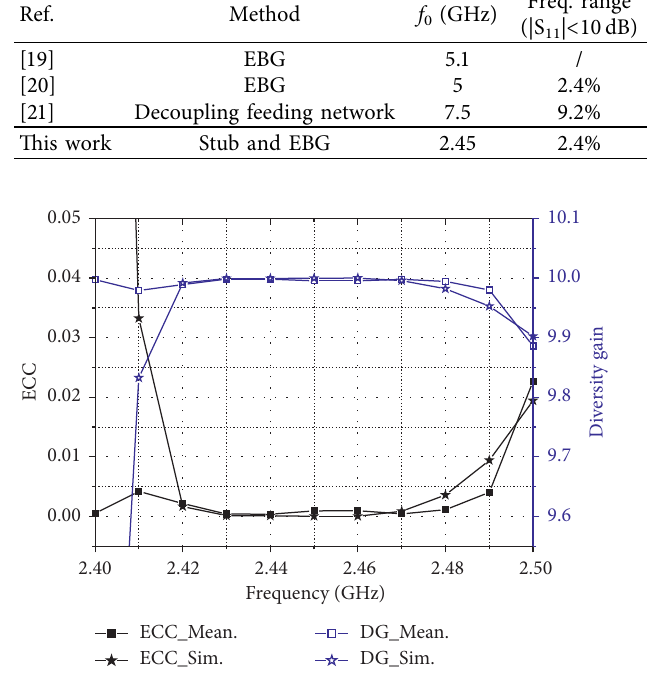
Figure 15: ECC and DG of the proposed antenna.